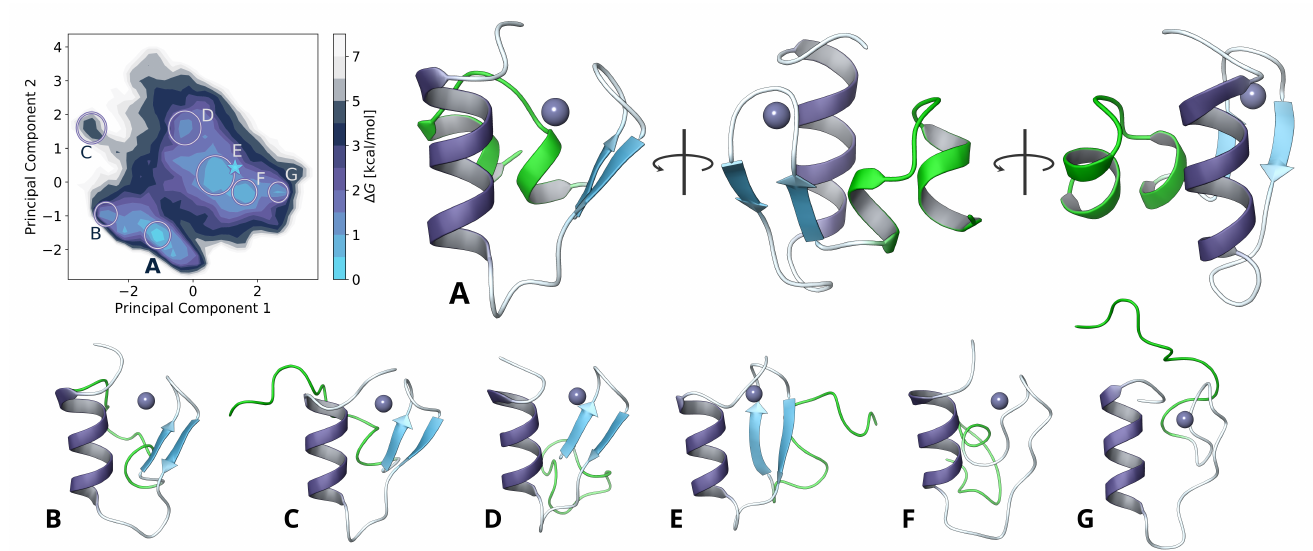
Figure 2. (top left) Free energy landscape obtained from TIGER2hs sampling and dihedral principal component analysis with global minimum ( A ) from different angles and other common structures ( B – G ) with different loop conformations colored in green. The initial homology modeled structure is highlighted by a blue star on the